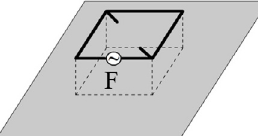
Fig. 1. Naturalloopantennasradiatingacircularlypolarizedwave with a single feed point F . The loop has perturbation elements [2].